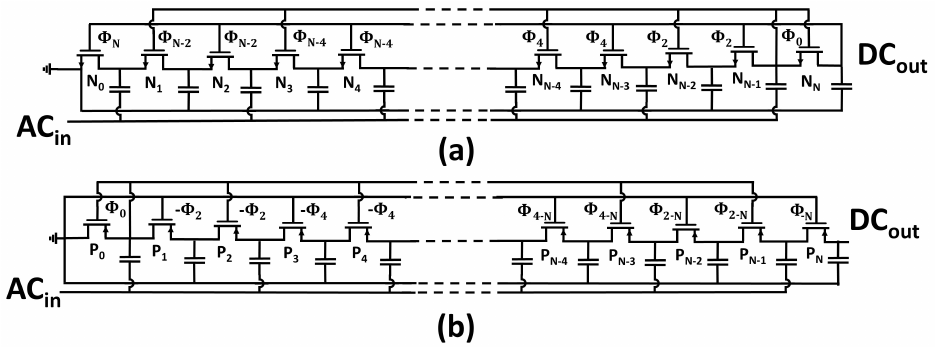
Figure 7. Voltage multiplier employing ( a ) NMOS and ( b ) PMOS transistors in the rectification chain, implemented maximizing the compensation